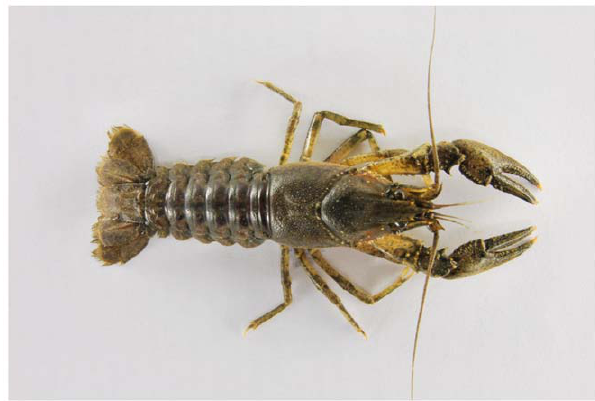
Figure 1. Mature female of the spiny-cheek crayfish Orconectes limosus from the Cˇernovicky´ brook (Czech Republic), a source population for our experiments. There was no difference in phenotype of females in the different experimental